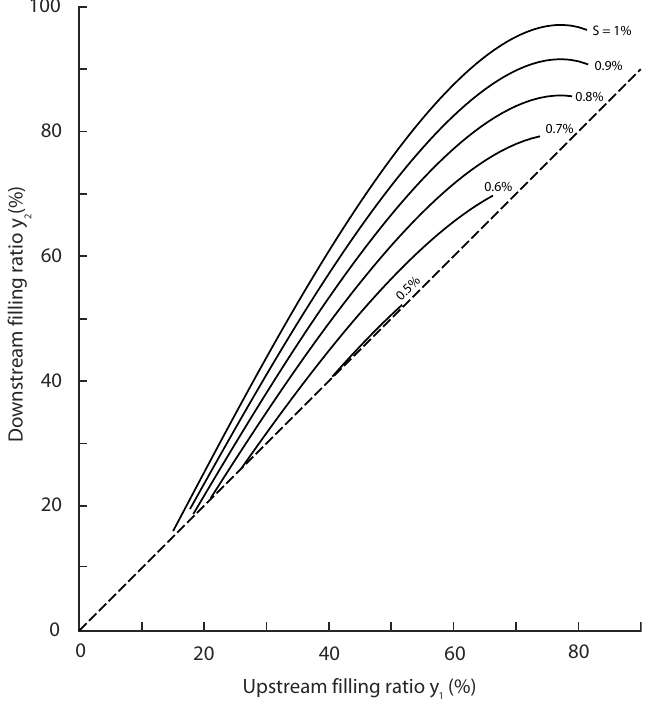
Figure 8. Filling ratio ( y 2 = h 1 c / D ) at the sequent depth section of undular hydraulic jumps in a circular pipe with a slope S = 0.5% to 1%. The pipe diameter is D = 600